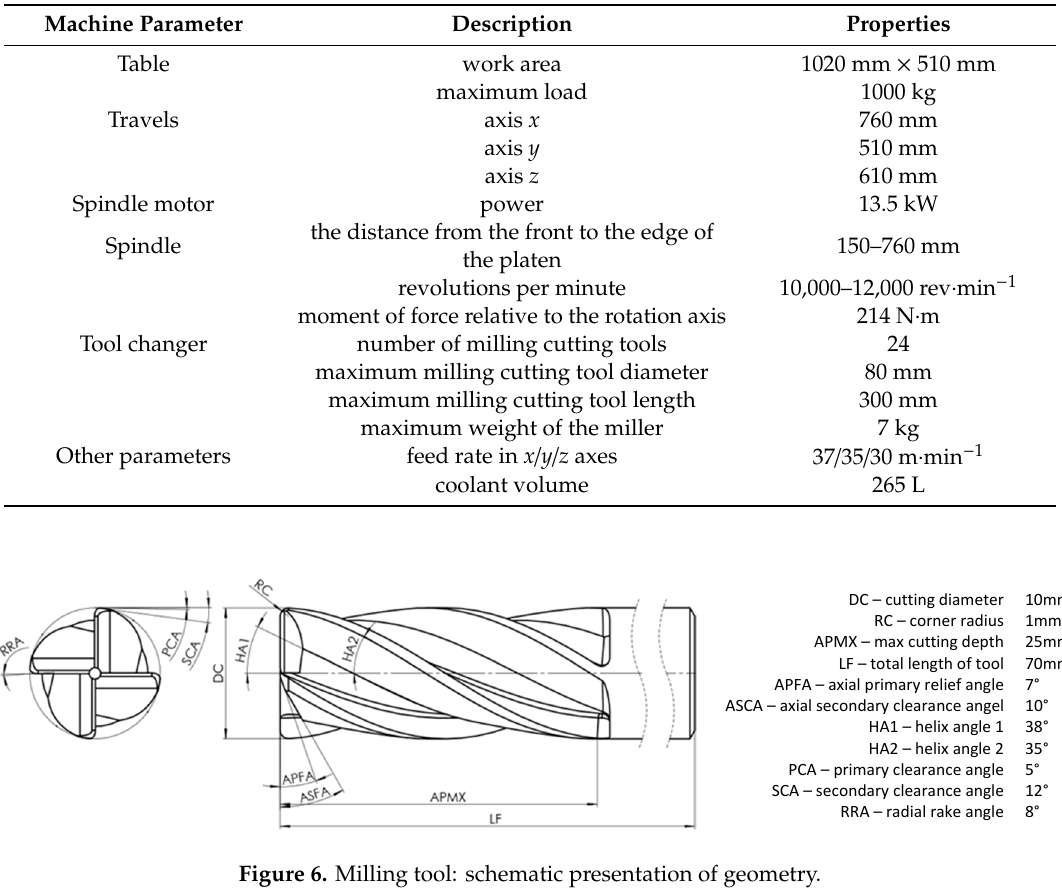
Table 1. Technical parameters of the used machine Hurco VMX-30-T.